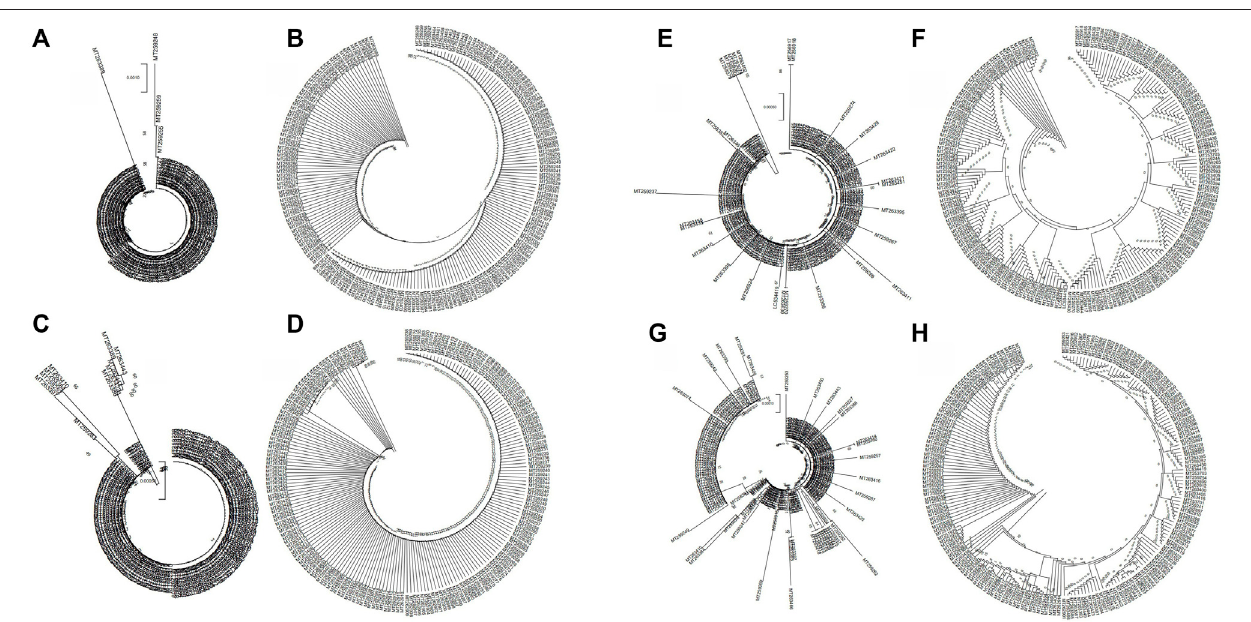
FIGURE 2 | Evolutionary characteristics of the structural genes of 200 severe acute respiratory syndrome coronavirus-2 (SARS-CoV-2) isolates. (A,B) : The two isolates with single nucleotide polymorphisms (SNPs) in the E gene were evolutionary distinct. (C,D) : The nine isolates with variations in the M gene were evolutionary distinct. (E,F) : The 28 isolates with variations in the N gene were evolutionarily distinct. (G,H) : The 88 strains with variations in the S gene evolutionarily